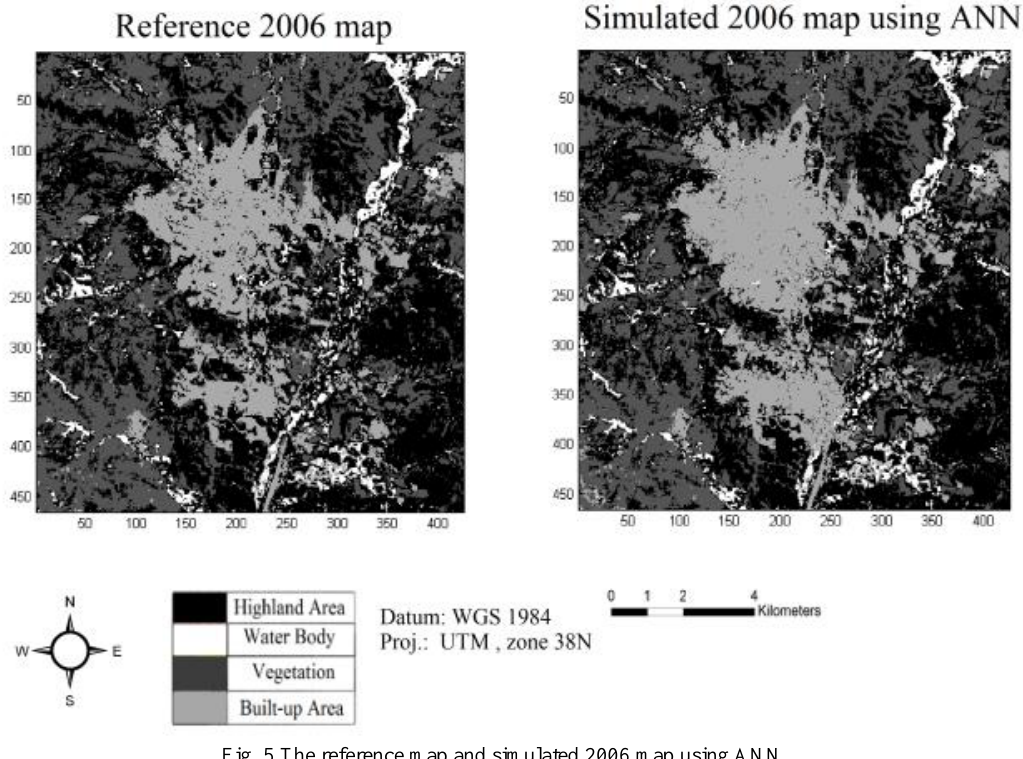
Fig. 5 The reference map and simulated 2006 map using